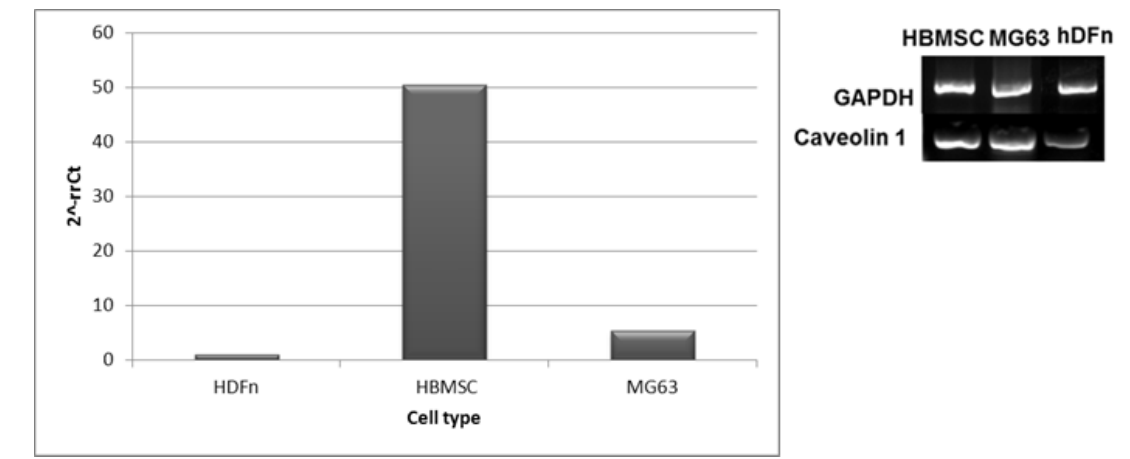
Figure 9. Reverse transcriptase PCR results with human stromal bone marrow cells (HBMSC), human osteoblast-like cells (MG63), and dermal fibroblasts (HDFn) (right image). qPCR of Caveolin-1 using the ∆∆ Ct method using GAPDH house-keeping gene expression. Results were normalized to the cells controls (basic medium) and are shown as fold change (left graph).